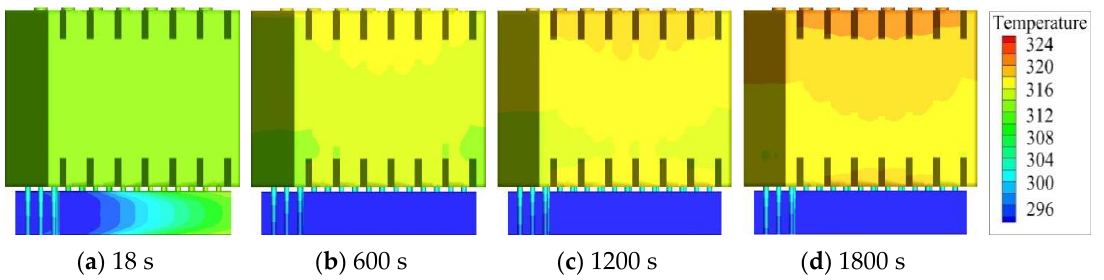
Figure 13. Temperature clouds graphs at 7 mm diameter of copper rod at 313 K ambient temperature.